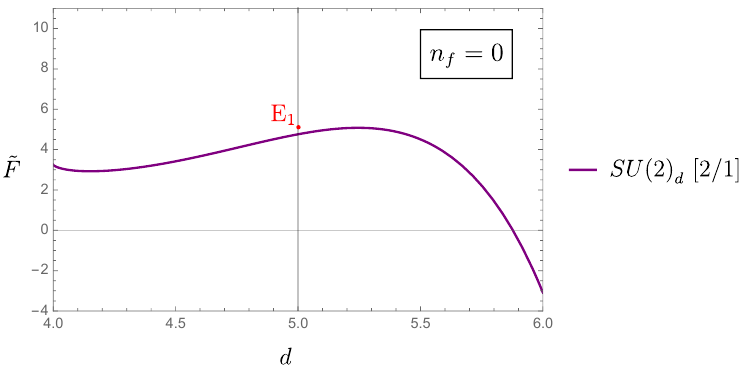
Figure 4 . Values of e F conf for pure SU(2) YM as a function of the dimension d computed with the Padé-approximant [2/1] (purple line), compared to the value of the 5 d supersymmetric fixed point E 1 , the UV completion of SU(2) SYM gauge theory (red